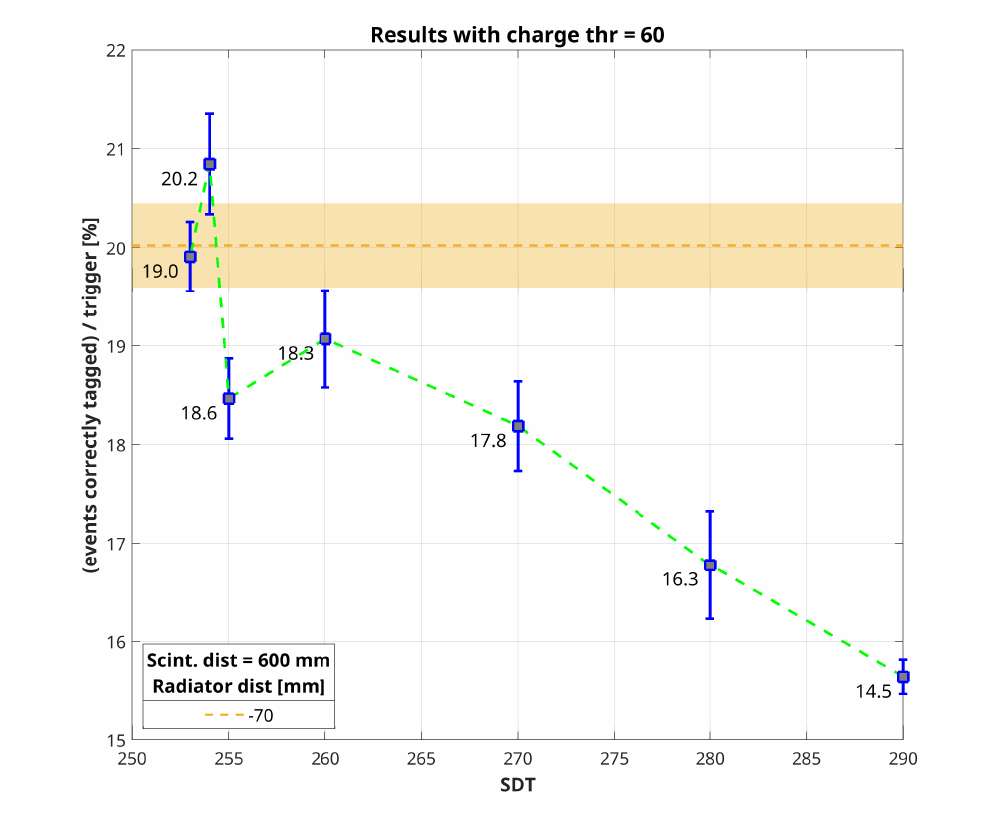
Figure 7. Comparison between the percentage of correctly tagged events with respect to the number of external triggers and the geometric efficiency calculated with a Monte Carlo simulation (dark yellow horizontal dashed line). This plot refers to values reported in Table 2, with charge threshold equal to 60 a.u. Values reported in the plot near the squared markers correspond to the net rate of correctly-tagged events, i.e., rate UP –rate DOWN in Table